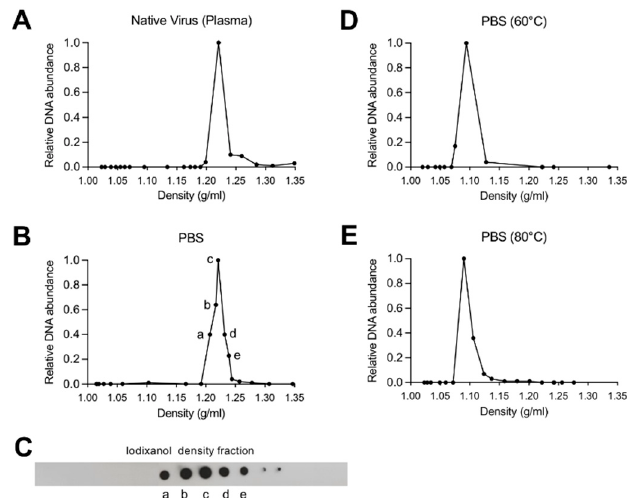
Figure 1. Buoyant density of native B19V from infected plasma or purified and resuspended in PBS. Fractions from iodixanol density gradient ultracentrifugation were collected and quantified by qPCR. ( A ) Density of B19V from infected human plasma. ( B ) Density of B19V purified from infected plasma by ultracentrifugation through 20% sucrose cushion and resuspended in PBS. ( C ) Detection of B19V capsids by dot-blot from density fractions of B19V in PBS. The corresponding fractions are indicated (a–e). ( D ) Density of B19V treated at 60 °C for 5 min. ( E ) Density of B19V treated at 80 °C for 5 min.